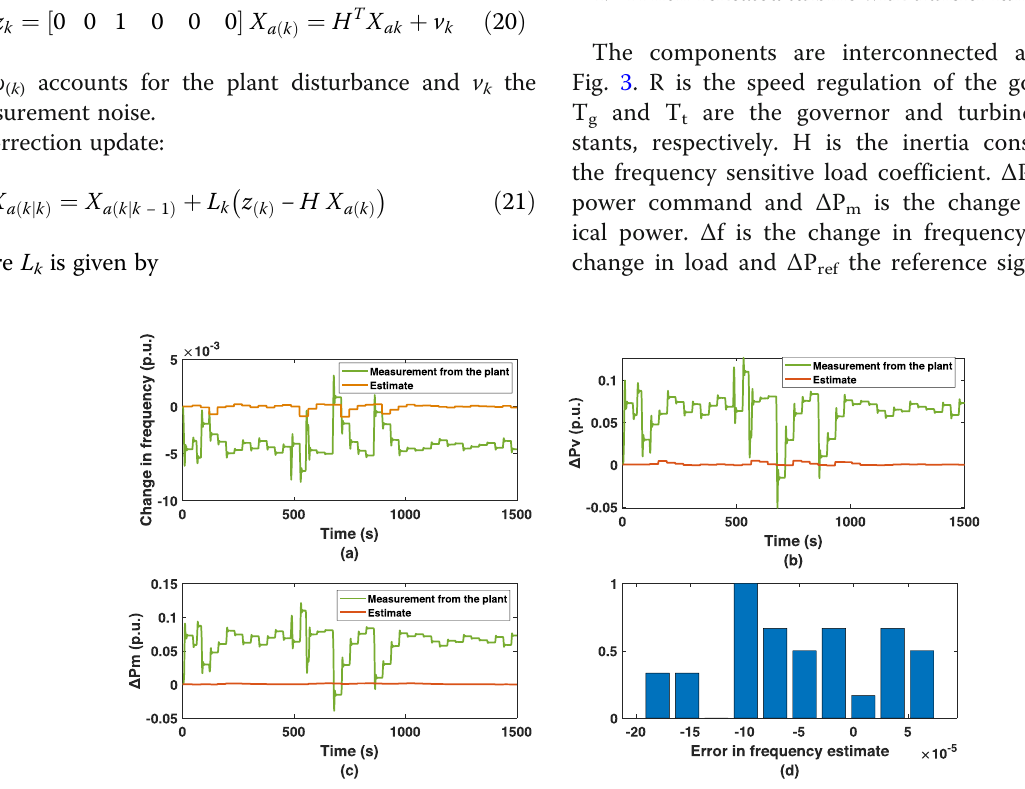
Fig. 9 a , b and c Variation of states Δ f, Δ P v and Δ P m in response to disturbance along with the estimate from the observer ( d ) Normalized histogram of error in frequency estimate for a measurement noise variance of